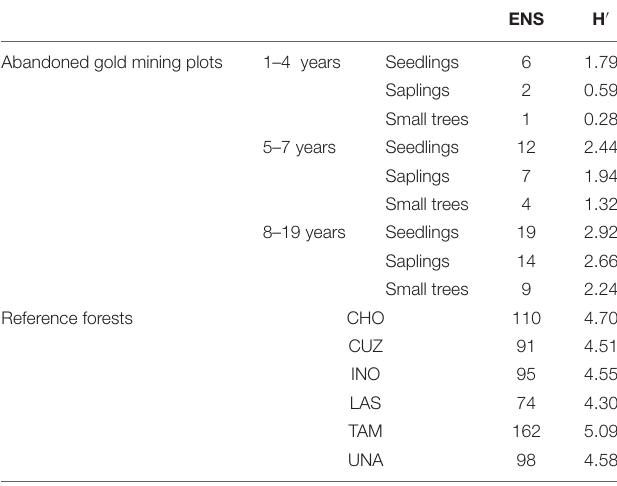
TABLE 2 | Richness and diversity for the abandoned gold mining and reference forests plots in Madre de Dios, southeastern Peru.